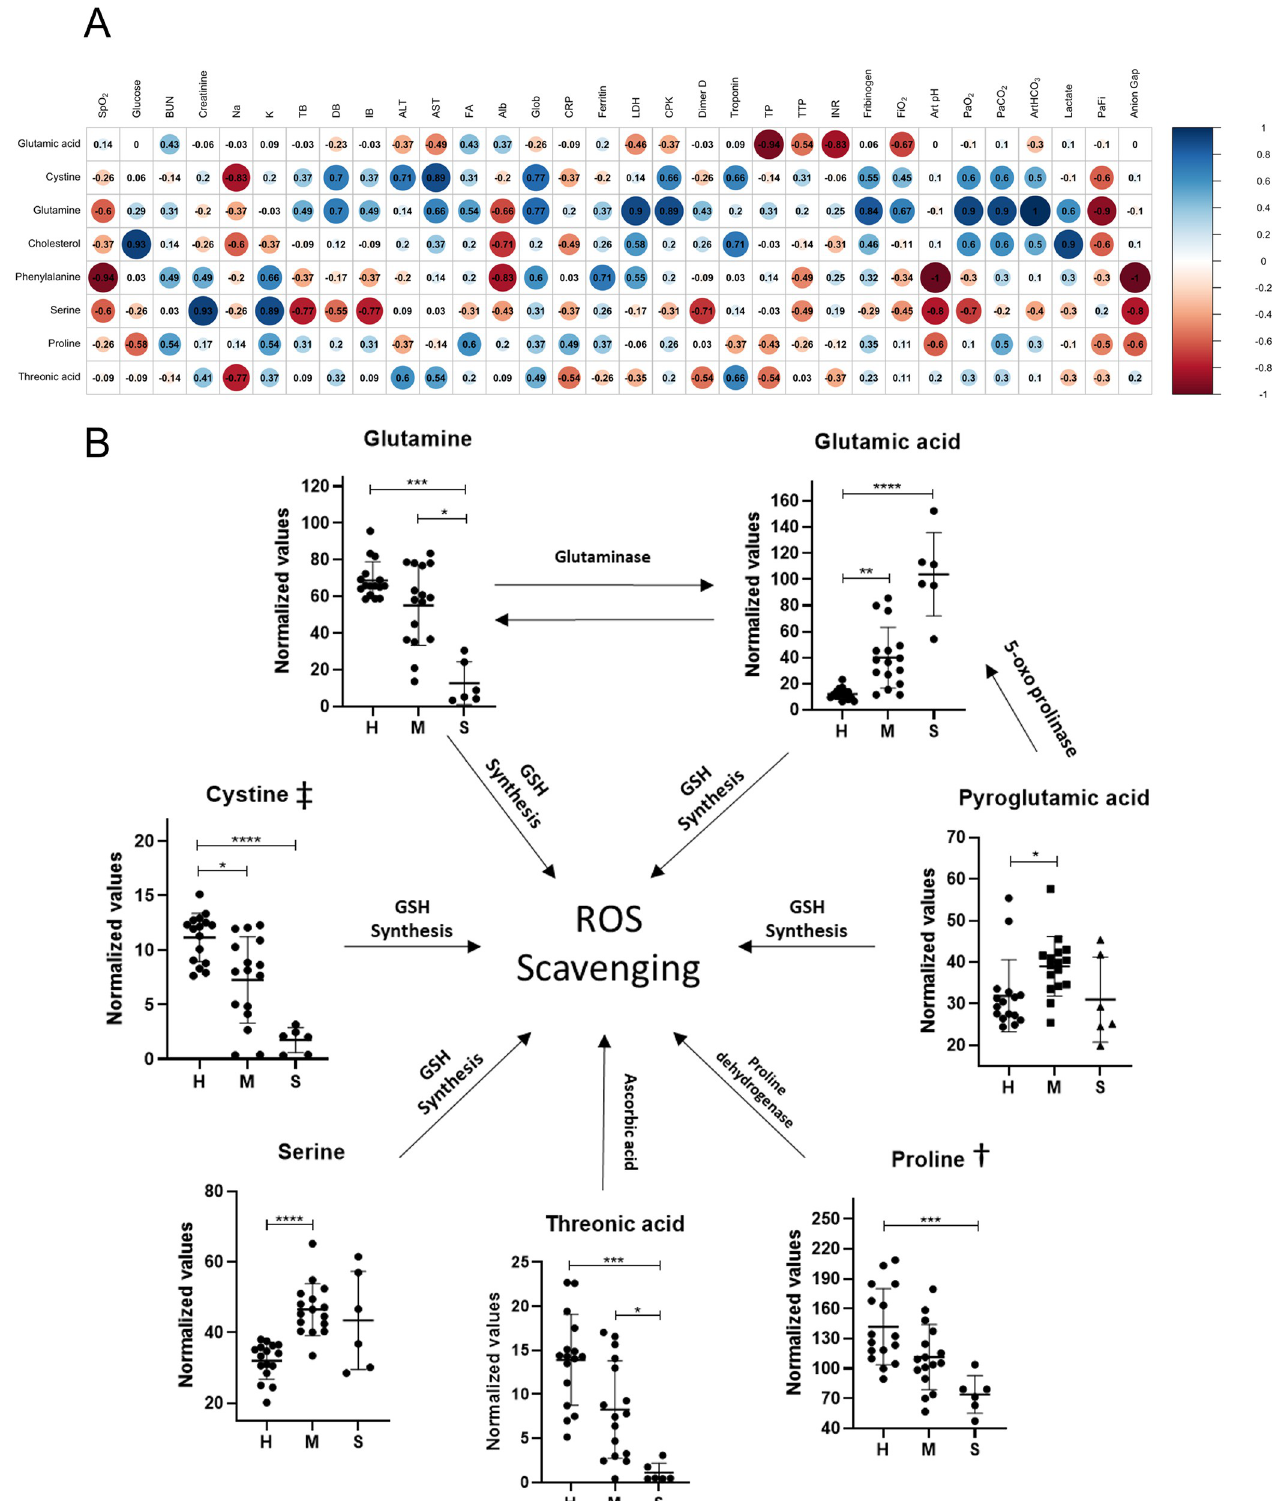
Fig 3. Correlation analysis of the metabolites and the clinical tests in the severe group. A. Spearman correlations analysis of metabolites and clinical tests. SpO2 = Oxygen saturation; LDH = Lactate dehydrogenase; Art pH = Arterial pH; PaO 2 = Partial pressure of oxygen; PaCO 2 = Partial pressure of CO 2 ;